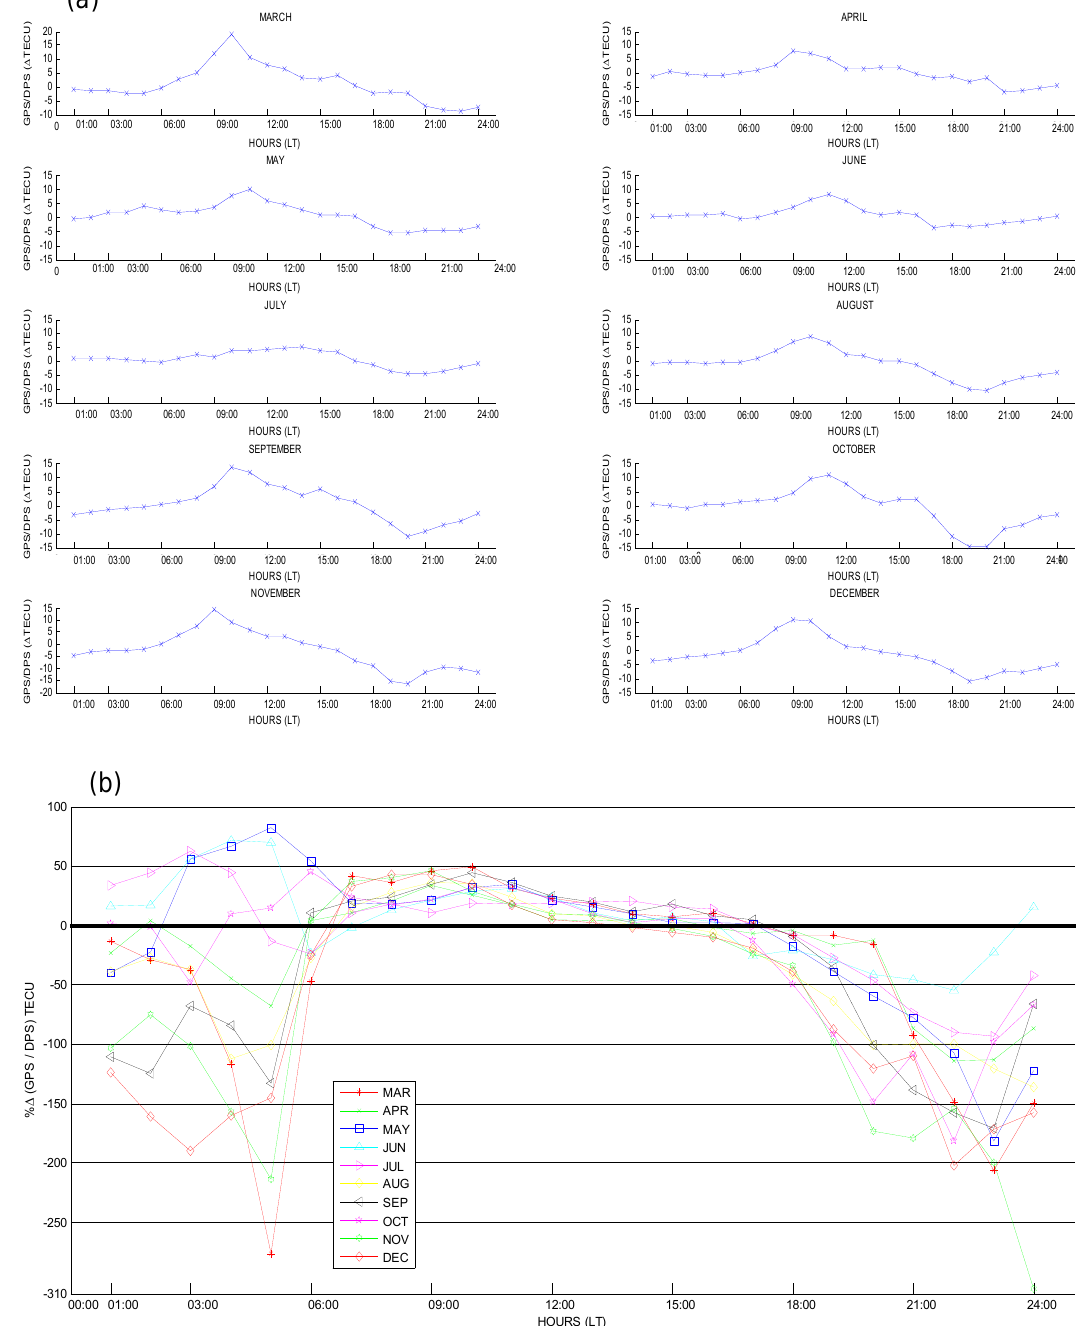
Figure 2. (a) Hourly variations in (cid:49) TEC between the GPS TEC and DPS TEC from March to December during a quiet period. (b) Mass plot of % (cid:49) TEC between the GPS TEC and DPS TEC from March to December during a quiet period. The legend represents line colors and symbols of each deviation in all